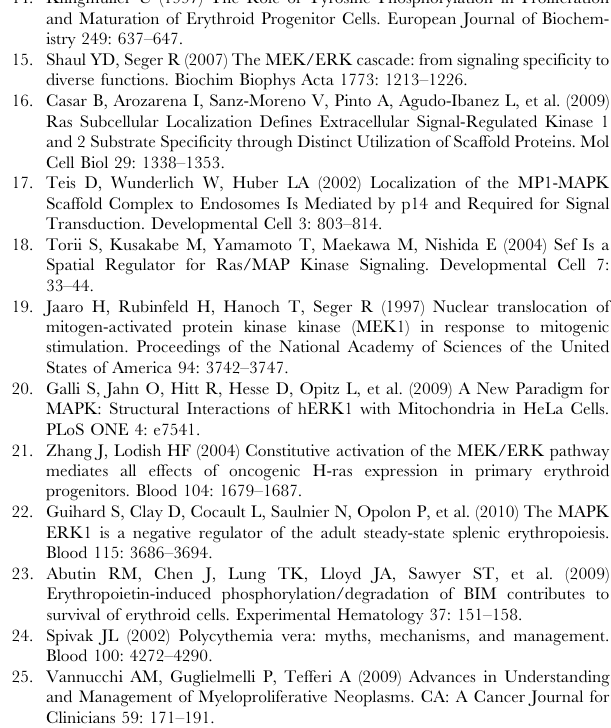
values in WT, IRP1 + / 2 and IRP1 2 / 2 mice treated for 23 days with (2 mg/kg/day). Data represent mean 6 SD; n =6 per group. percentages of cells in R1–R4 6 SD; n= 3 per group. Table S1 CBC parameters of WT mice treated for four weeks with saline (0.9%) or FA (2 mg/kg/day). Table S2 CBC parameters of PV mice treated for four weeks with saline (0.9%) or FA (2